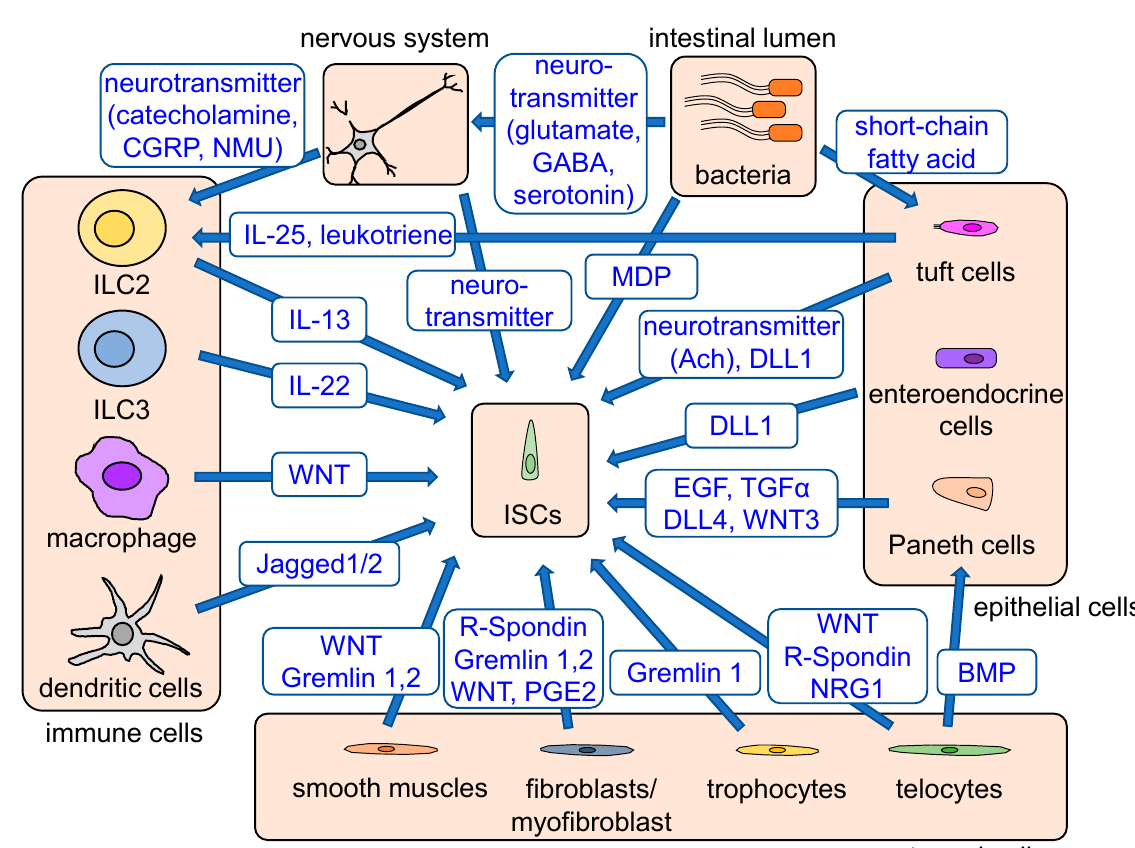
Figure 2. Stem cell niches and regulatory signals. Stem cell niches consist of epithelial cells, stromal cells, immune cells, bacteria, the nervous system, and other signals. Paneth cells, interspersed between Lgr5+ CBC cells, secrete EGF, TGF α , DLL4, and WNT3 and maintain stem cell functions. When Paneth cells are ablated, tuft and enteroendocrine cells act as a complementary source of Notch signaling. Fibroblasts maintain stem cell functions by producing WNT, R-spondin, gremlin, and PGE2. Foxl1+Pdgfra High telocytes provide Wnt, R-spondin, and BMP, while CD81+Pdgfra Low trophocytes at the crypt bottom secrete BMP antagonists and gremlin 1 to strengthen WNT signaling. WNT and BMP antagonists are also secreted from smooth muscles. The cytokines secreted from immune cells, including Wnt-producing macrophages, Jagged-producing dendritic cells, IL13-producing ILC2s, and IL22-producing ILC3s, have an important role in stem cell regulation and epithelial regeneration. Enteric bacteria either directly or indirectly regulate stem cell functions via production of MDP, which supports ISC survival and activation of the tuft cell–ILC2 immune circuit through their metabolites. Tuft cells are involved in the activation of ILC2s via production of IL-25 and leukotrienes. Enteric nerves and tuft cells support ISC functions via production of acetylcholine, and various neuron-derived products can stimulate ILC2s, which support ISC function. Major signals provided from stem cell niches are shown in blue.